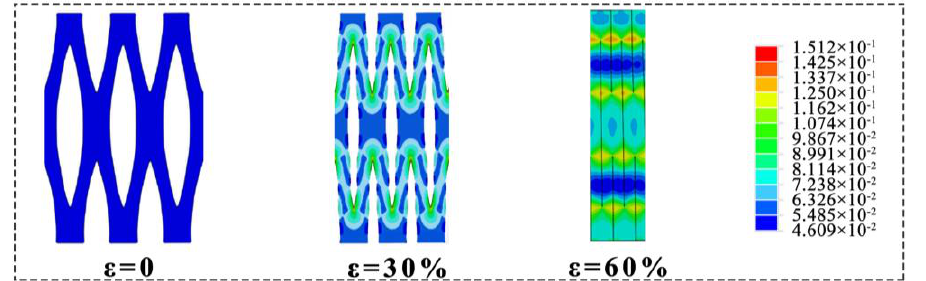
Figure 3. As the compressive strain rises, FEM simulation depicts the evolution of the maximum principle strain distribution.